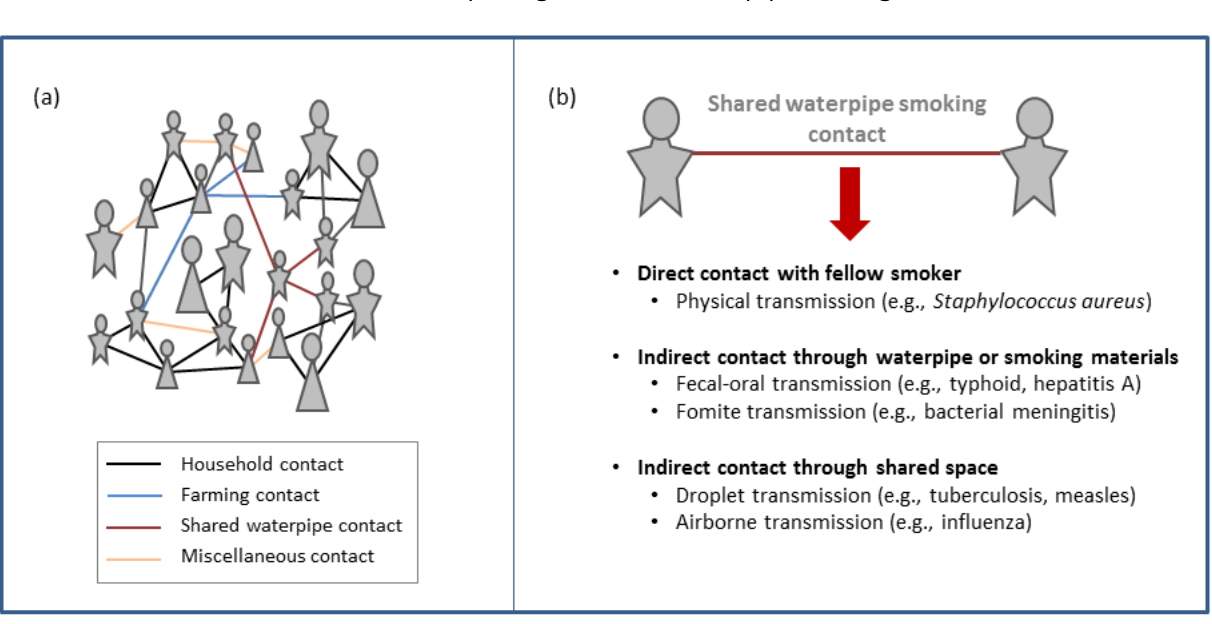
Figure 2. ( a ) Hypothetical network of potential disease-causing contacts in a rural Lao community, highlighting the possibility of additional links in an individual’s